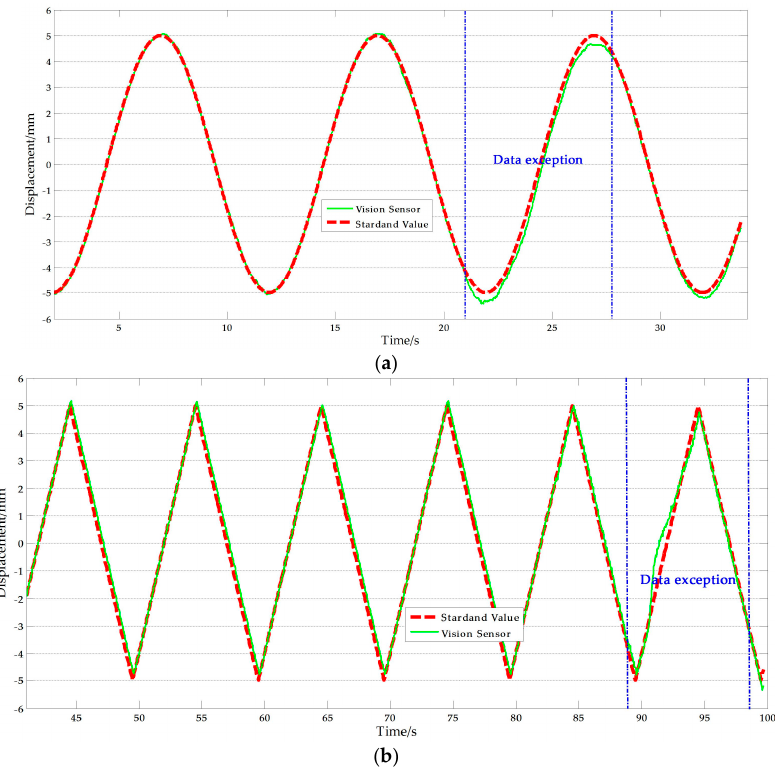
Figure 12. Exceptional artificial measurement results: ( a ) Ι -2; ( b ) Ι -4.